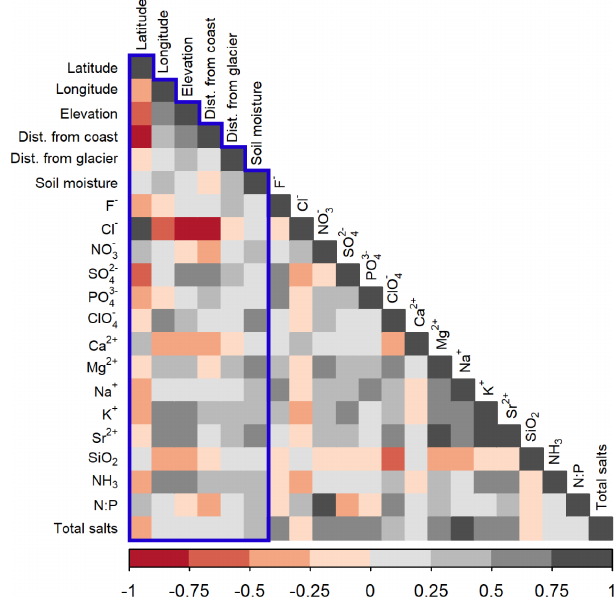
Figure 5. Spearman’s rank correlation matrix generated in r using the corrplot library. The colors represent correlation coefficients, in- dicating the strength and magnitude of the correlation. The blue box indicates the geographic variables and soil moisture, which were variables used in the multiple linear regression and random forest models. Familywise Type 1 error corrections were not applied in this